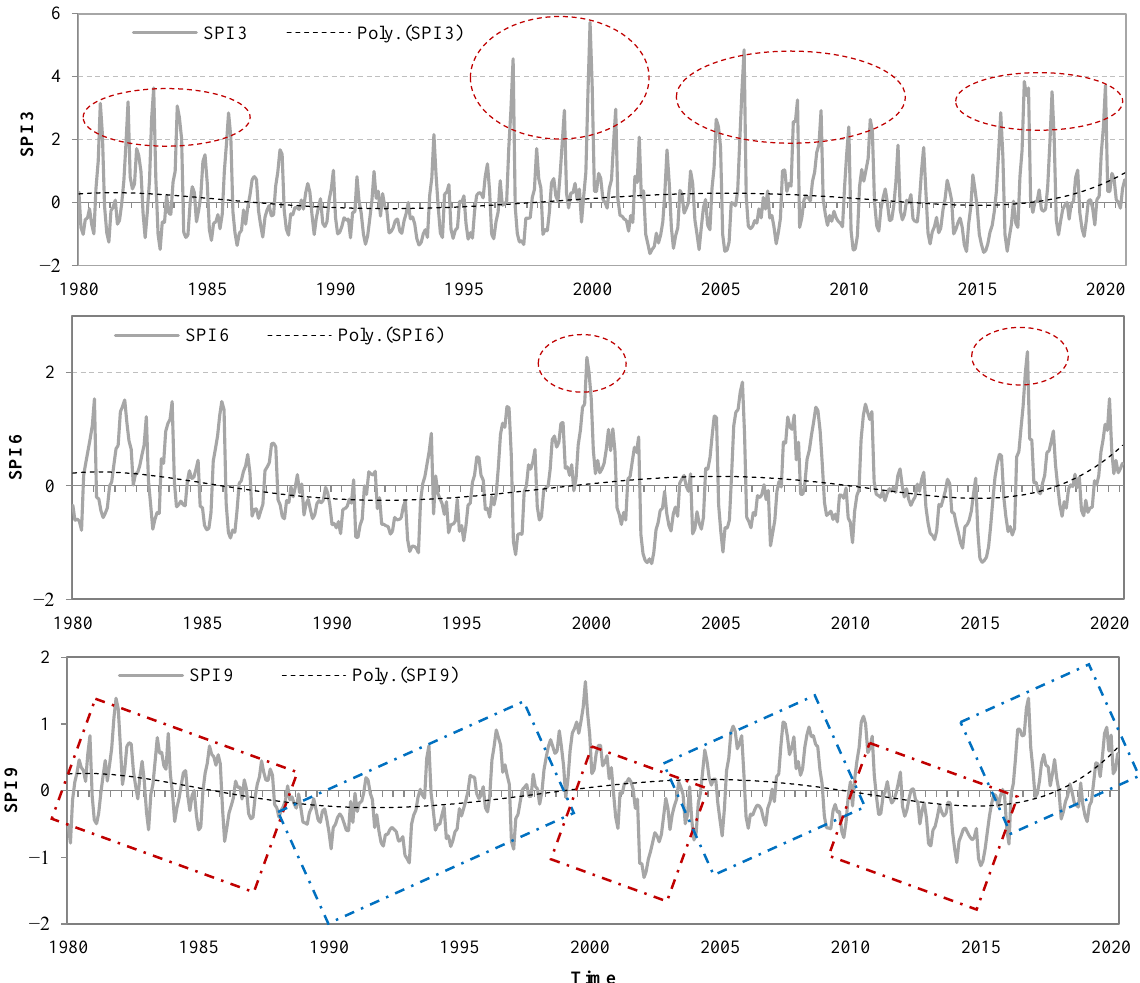
Figure 2. The overlap diagram for determining the land use change area for the period of 2010 to